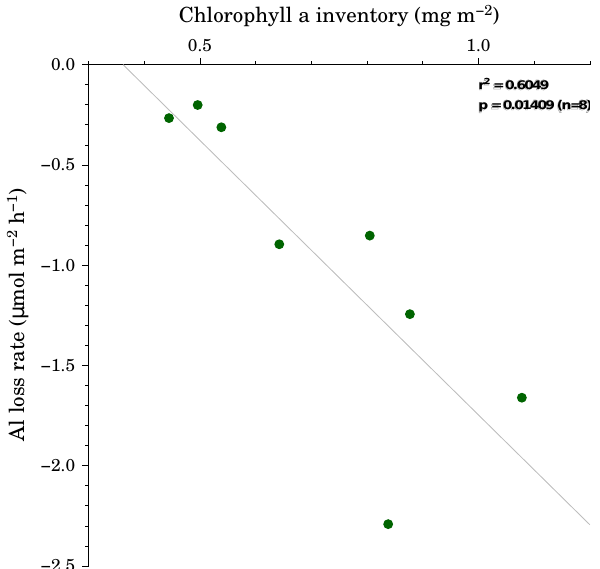
Fig. 6. Correlation of Al loss rate vs. the chlorophyll a